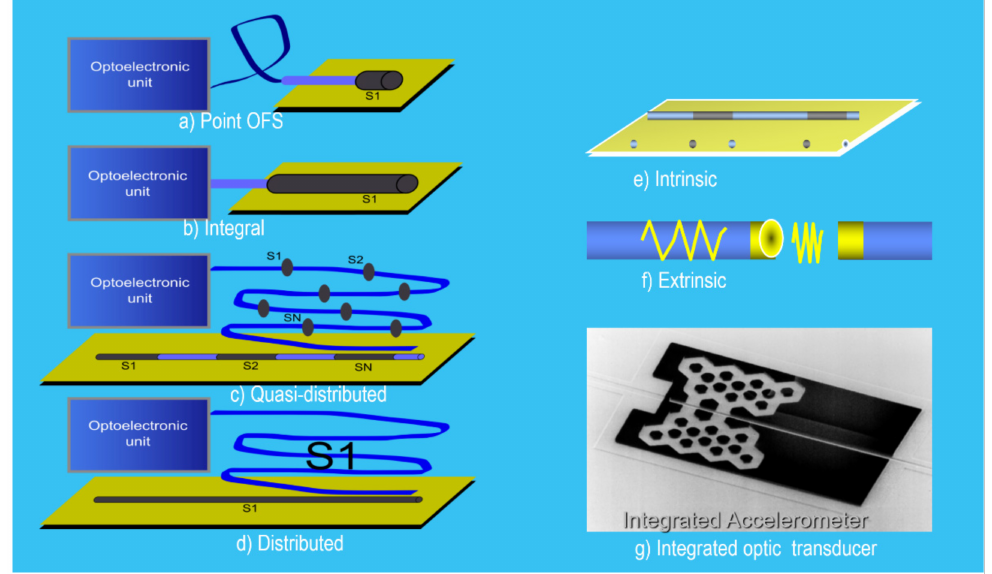
Figure 6. Illustration of photonic sensors according to the technology and the interaction of light-Oy- Mx: ( a – f ) Optical Fiber Sensors and ( g ) Integrated Optic Sensor. Courtesy of the